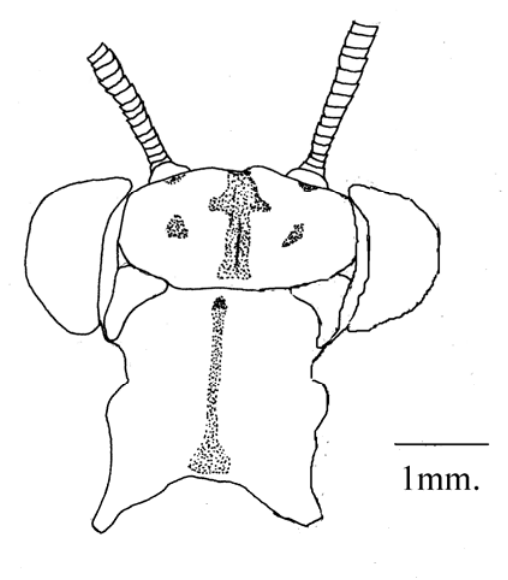
F IG .3.- head and pronutum Wings: Fore wings: 29.6mm, hind wings 28.3 mm, both yellowish transparent without any spots.Pterostigma, distinct, whitish. Hind wing, inner radial field (irf) with four cross veins, fore wing with six cross veins (fig 4).